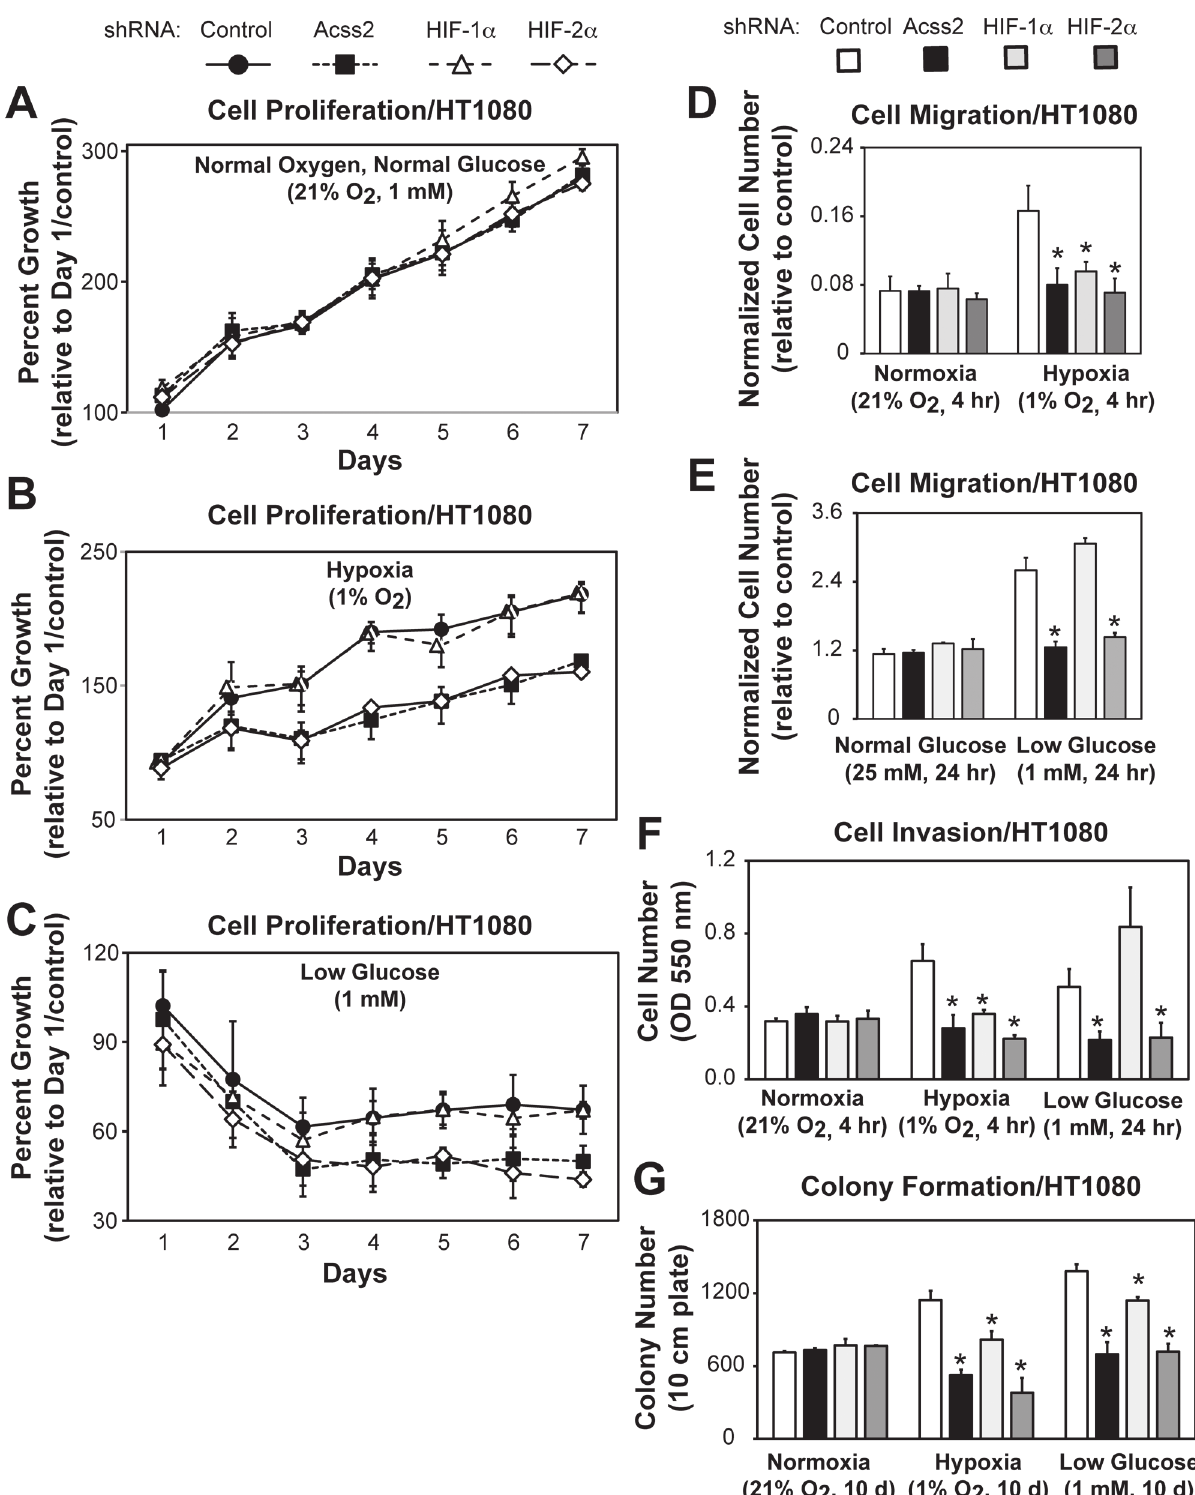
Fig 6. ACSS2 and HIF-2 α regulate in vitro tumor cell properties. Cell proliferation assessed by cell survival for stably transformed HT1080 cells exposed to either (A) ambient, (B) hypoxic, or (C) low glucose conditions (n = 8/treatment/day) and expressing control (black circles), ACSS2 (black squares), HIF-1 α (white triangles), or HIF-2 α (white diamonds) shRNA. Cell migration assessed for same control (white bars), ACSS2 (black bars), HIF-1 α (light gray bars), or